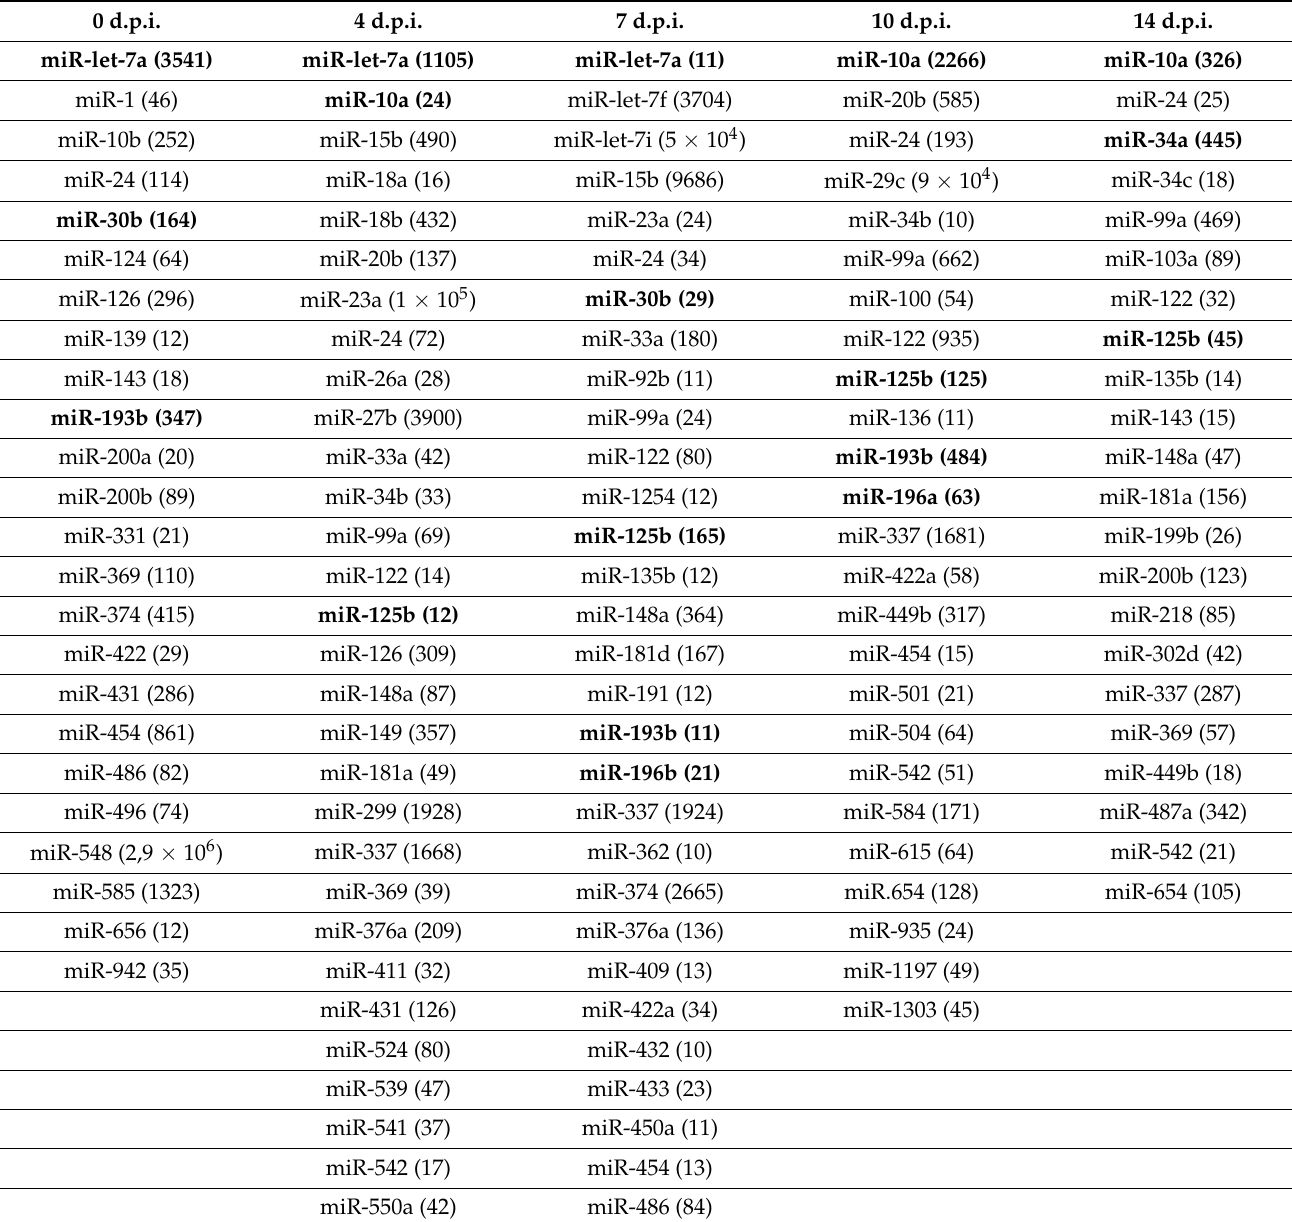
Table 3. Most down-regulated (>10-fold) miRNAs in HCMV-infected human fibroblasts at 0, 4, 7, 10 and 14 days post- infection (d.p.i.)